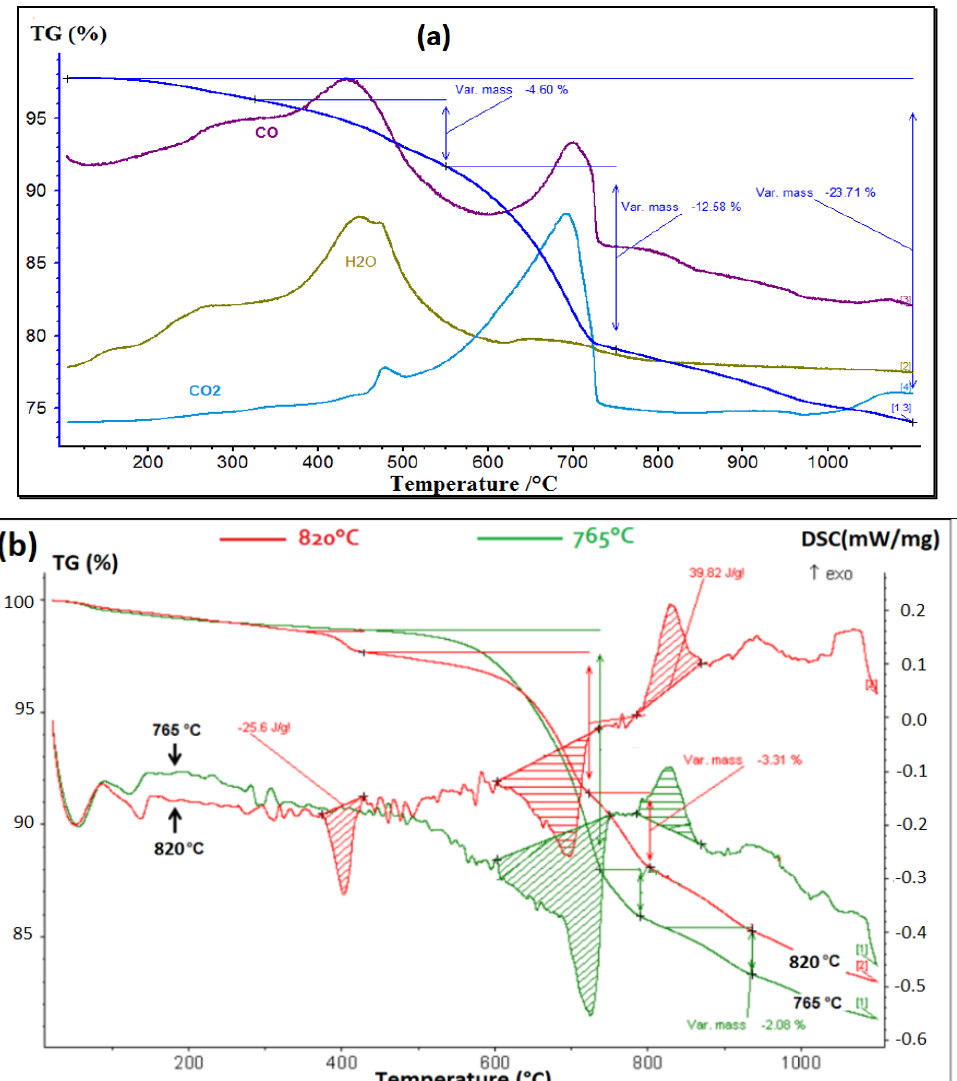
Figure 5. ( a ) TGA results for RS and ( b ) TGA on pre-flash-calcined sediment (STFC).